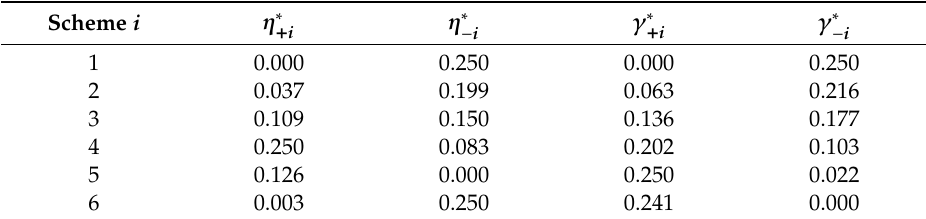
Table 11. Weighted standardized derivative indicator decision matrix C